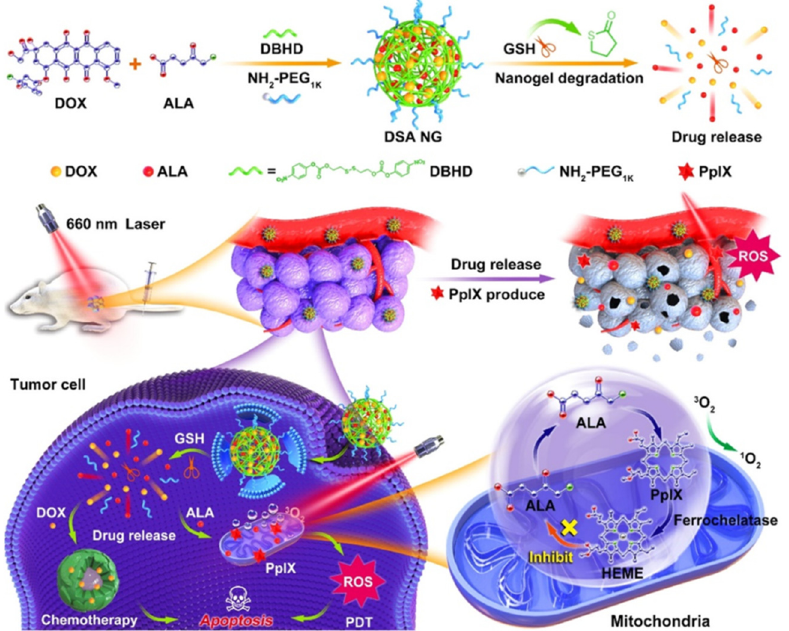
Figure 3. A glutathione-responsive multifunctional nanogel loaded with 5-aminolevulinic acid (5-ALA) photosensitizer and doxorubicin (DOX) for chemo/photodynamic combination cancer therapy. Reproduced with permission from [49]. Copyright 2010. American Chemical Society.